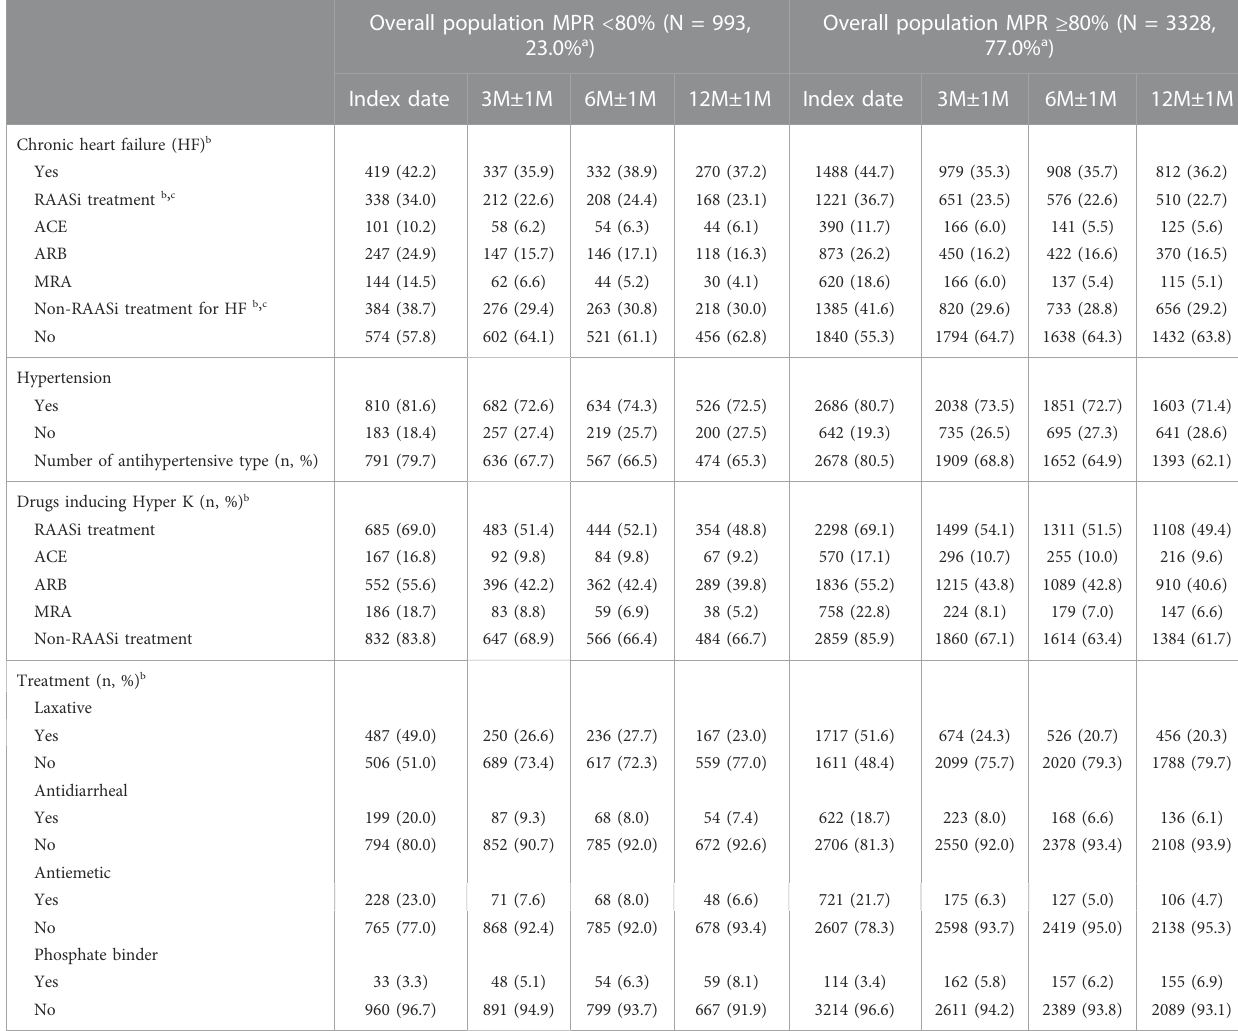
TABLE 2 Treatments prescribed during the follow-up period (overall population).